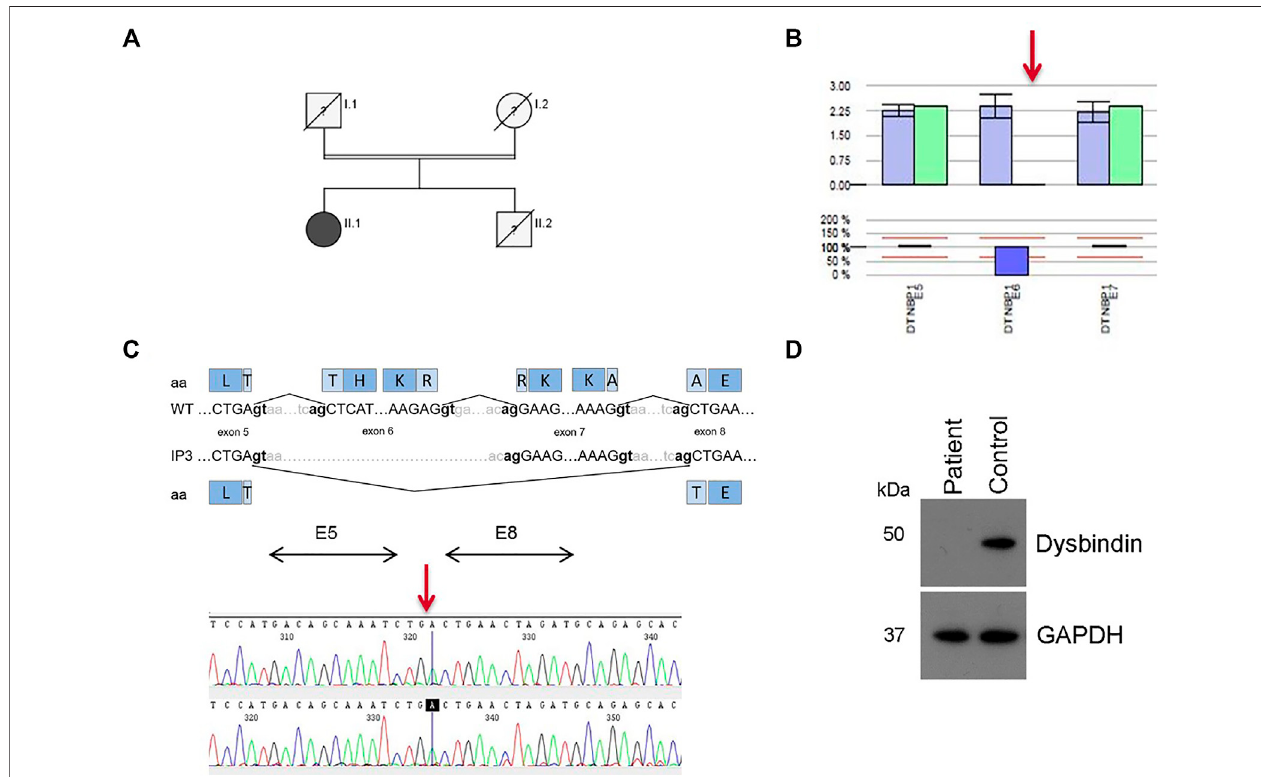
FIGURE 2 | Results for patient IP3 (HPS-7). (A) Pedigree for IP3 (II.1). Her consanguine parents and her brother are already deceased, her brother presented with OCA and bleeding disorder. (B) Bioinformatics software SeqPilot CNV analysis indicates a homozygous deletion of exon 6 in DTNBP1 . (C) Upper Panel: Schematic representation of the normally spliced mRNA (WT) and the aberrantly spliced mRNA of IP3. Lower Panel: cDNA sequencing of platelet derived DTNBP1 mRNA shows deletion of exon 6 and 7 in IP3. (D) Dysbindin expression in gel- fi ltrated platelets of the patient (IP3) and a healthy volunteer performed by Western analysis: Dysbindin is not expressed in patient ’ s platelets. GAPDH (37 kDa) was used as loading control (lower bands).